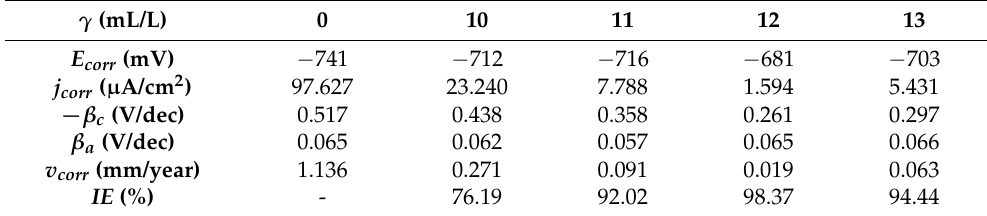
Table 3. Electrochemical parameters determined from polarization curves scanned on the carbon-steel sample in the simulated brine saturated with CO 2 with and without inhibitor in static conditions (Data from